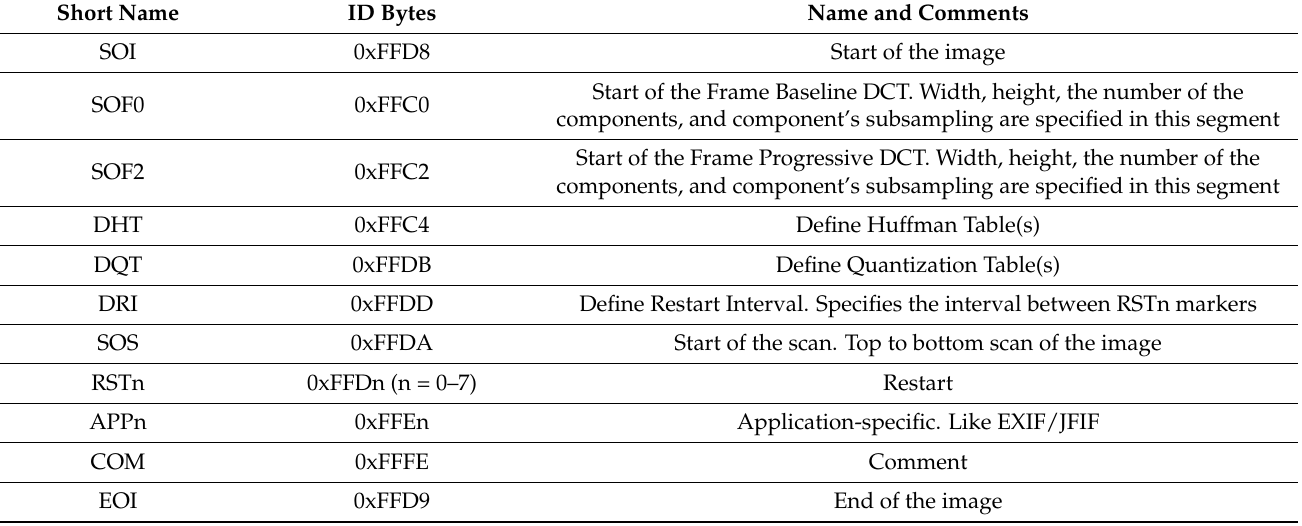
Table 2. List of common jpeg